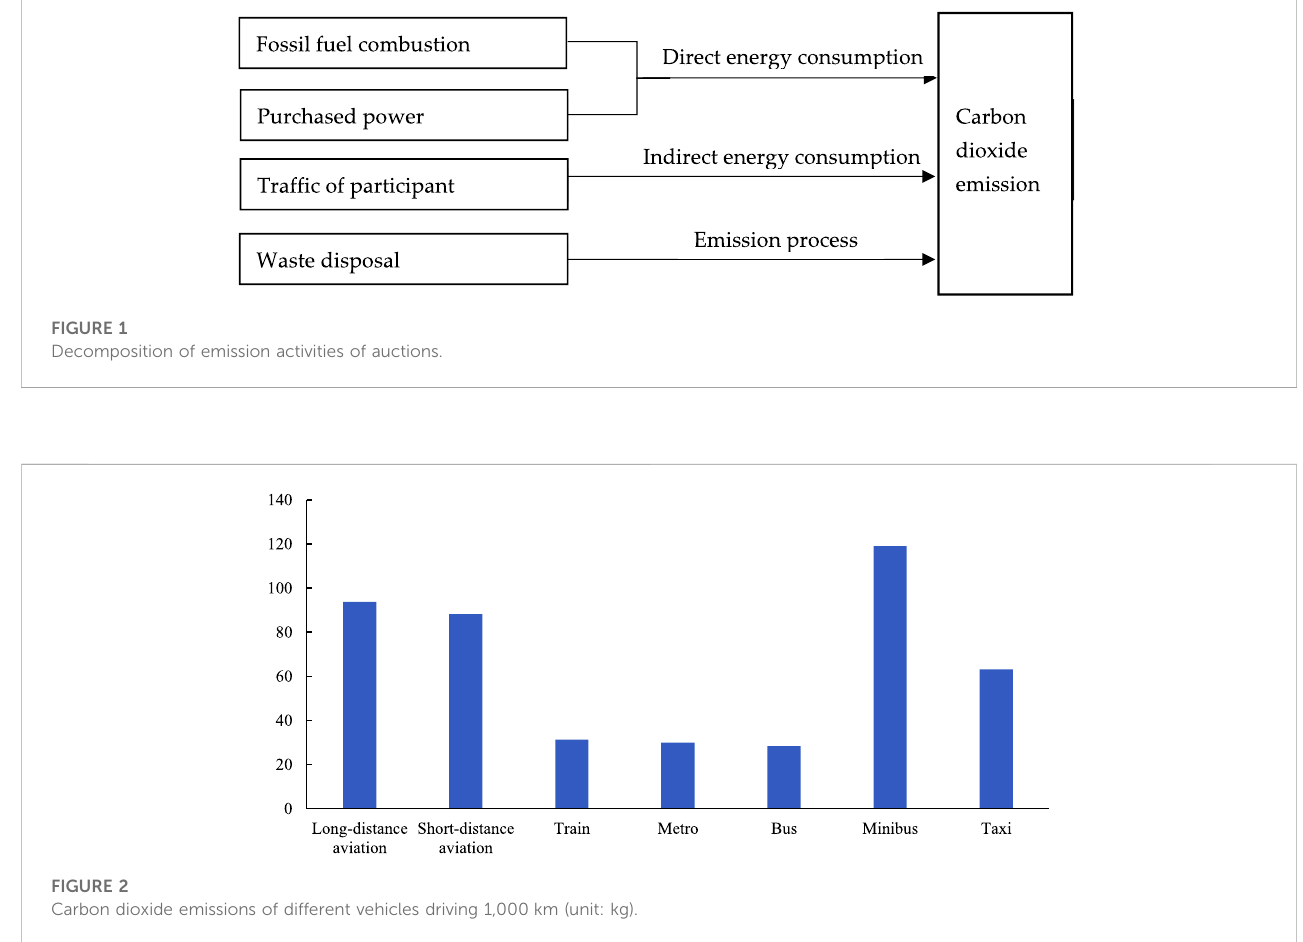
refers to the average power emission factor whose unit is ton/Kwh. AD Tj is the activity data on the j th vehicle, which is equal to the average round- trip distance of a person multiplied by the number of people. EF Tj is the